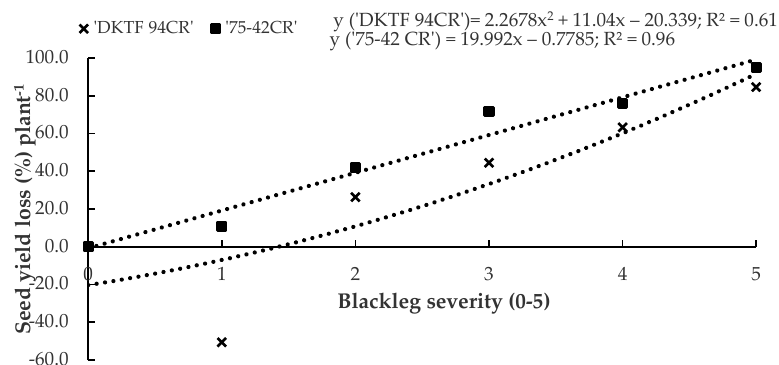
Figure 5. Relationship between blackleg severity and yield loss in the canola hybrids ‘DKTF 94C’ and ‘75-42CR’ sampled in 12 commercial fields around Lacombe and Wetaskiwin, AB, Canada, in 2019. The yield loss data were estimated using the y-intercept in the equation averaged over 12 commercial fields. The data points were transformed into the percentage of the maximum yield.